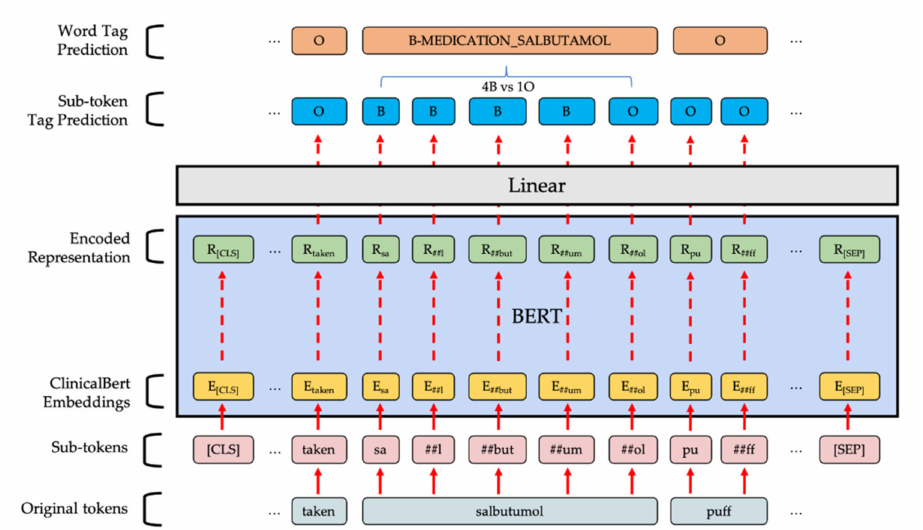
Figure 2. Illustration of our BERT-based token classification model. Sub-tokens with ## as prefix are split from original tokens and will have different embeddings compared to the ones with same spelling but without